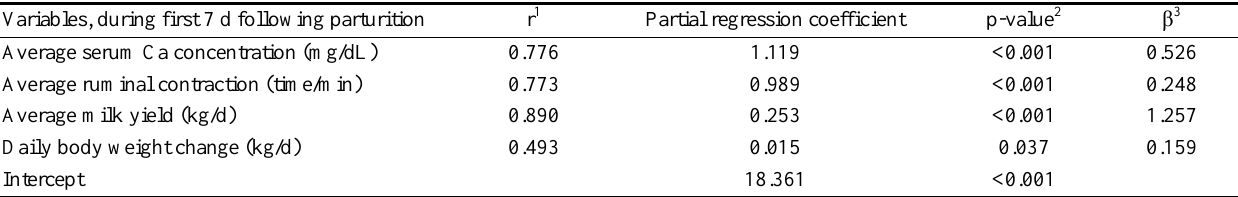
Table 5. Multiple regression analysis for average DM intake during first 7 d following parturition (kg/d, R 2 = 0.824, p<0.001) Variables, during first 7 d following parturition r 1